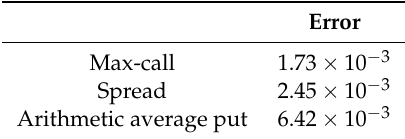
Table 1. Error for different multi-asset American